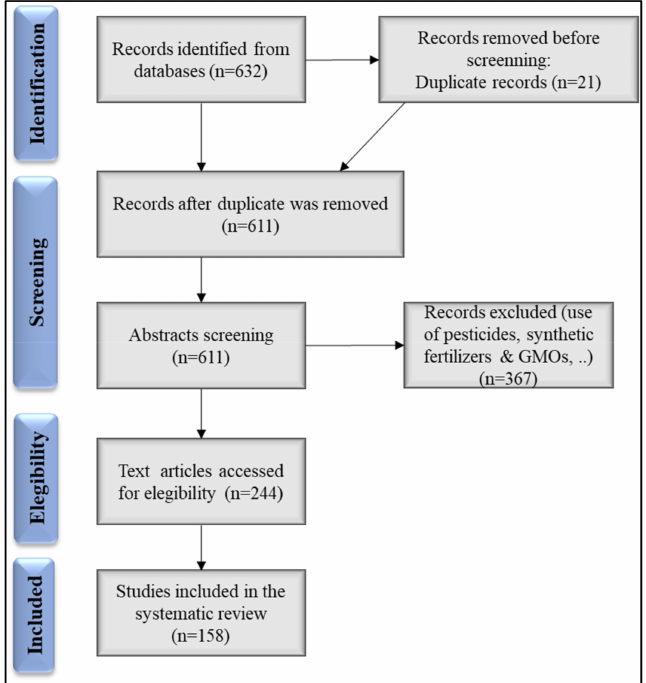
Figure 1. Diagram flow showing the research steps for article